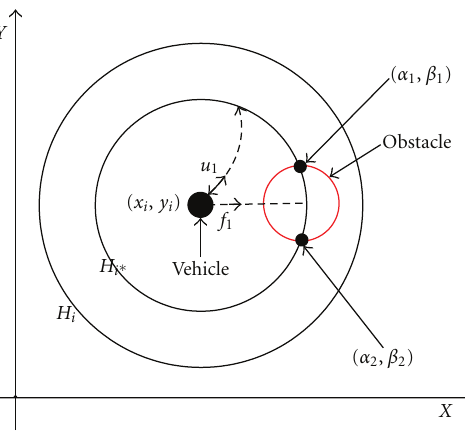
Figure 5: Collision avoidance with a small